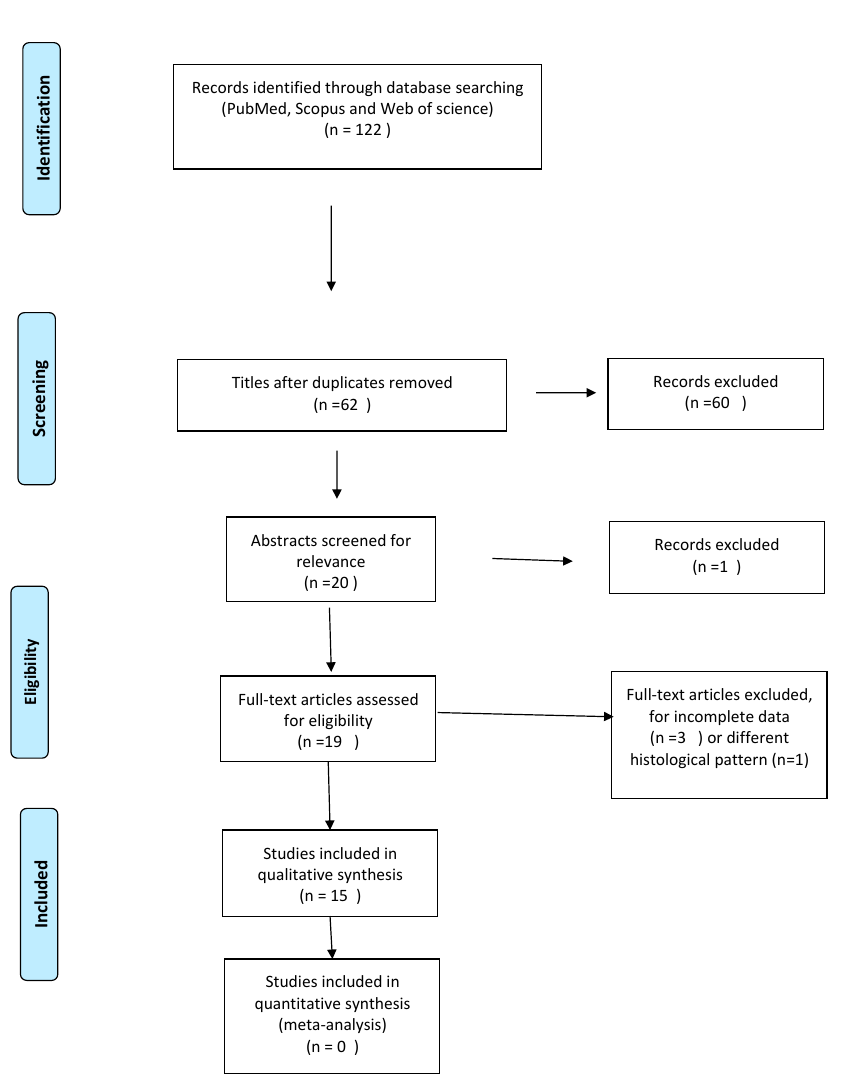
Figure 6. Flow chart articles exclusion .